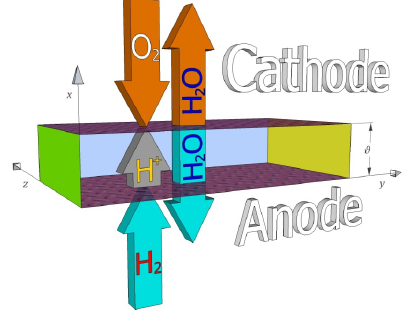
Figure 3. Schematic representation of species production, consumption and transport in the MEA. The two ribbed purple surfaces represent the catalyst layers at the MEA/GDL interfaces. The brown arrows represent the species transport from/to cathode gas part, whilst cyan arrows indicate the species transport from/to the anode gas part and the grey arrow represents the proton flow across the membrane. Hydrogen and oxygen are consumed on the anode and cathode catalyst layer respectively. All the water is produced on the cathode catalyst layer and the molar flux of water traversing the membrane is equal to the flux entering the anode gas